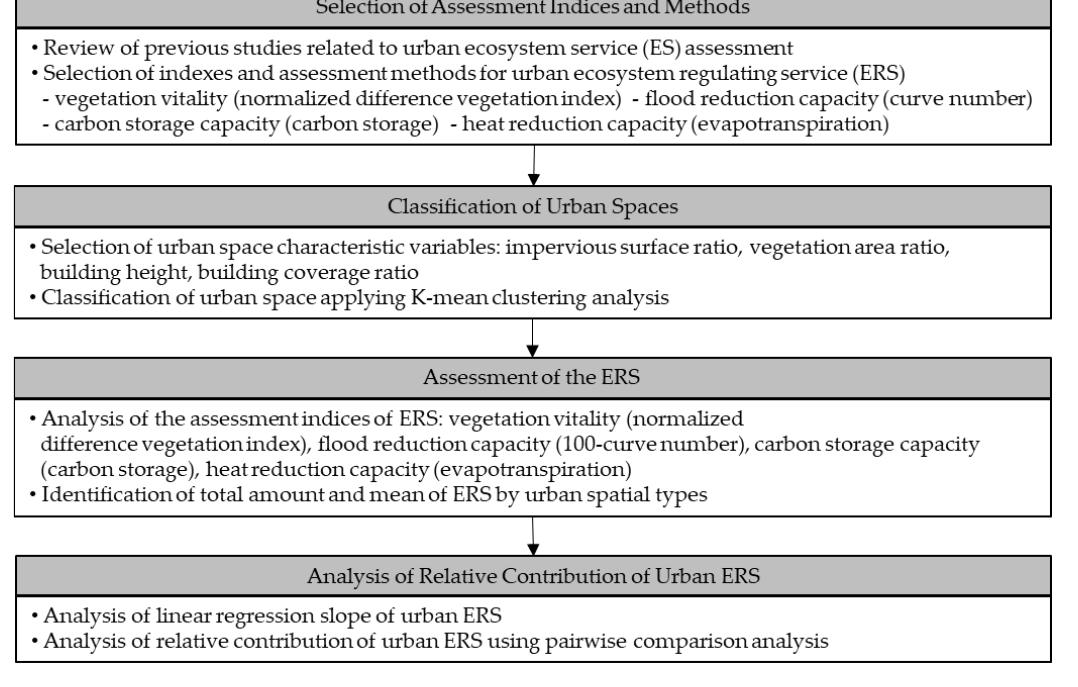
Figure 1. Study procedure .